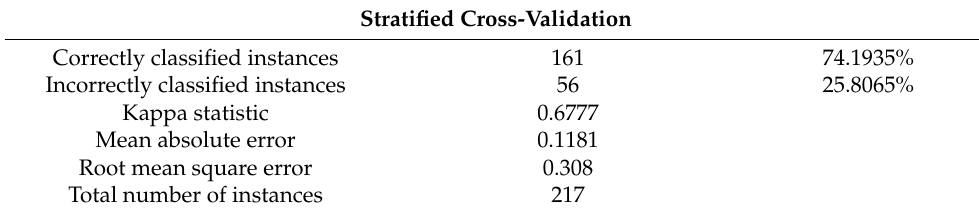
Table 20. Stratified cross-validation with re-evaluation on test